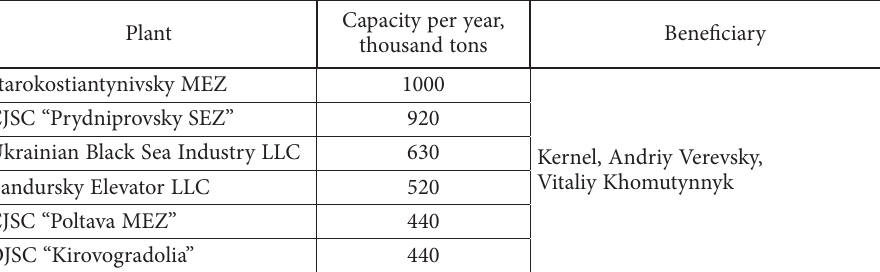
Table 1. Production capacity for sunflower processing in Ukraine, 2020 (source: compiled by the au- thors based on Lysohor, 2021)